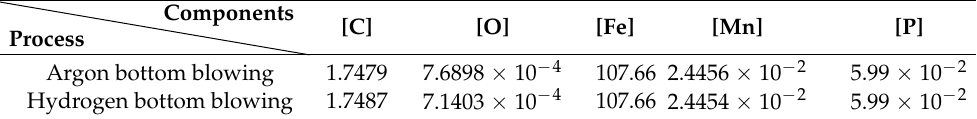
Table 15. Mass of some components in middle periods of the two types steelmaking processes (kg).